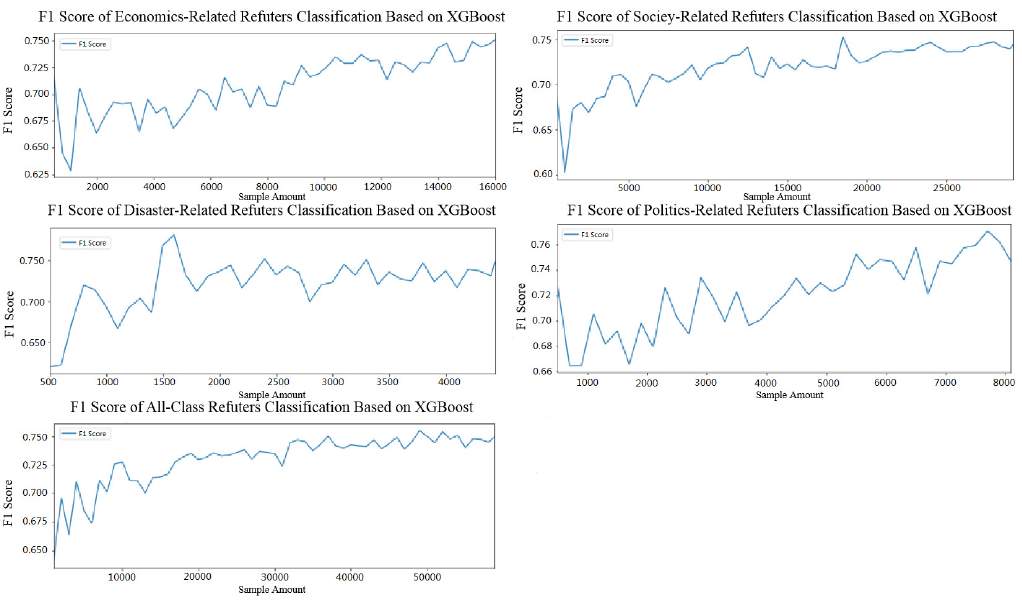
Figure 4. Refuter classification results based on XGBoost.